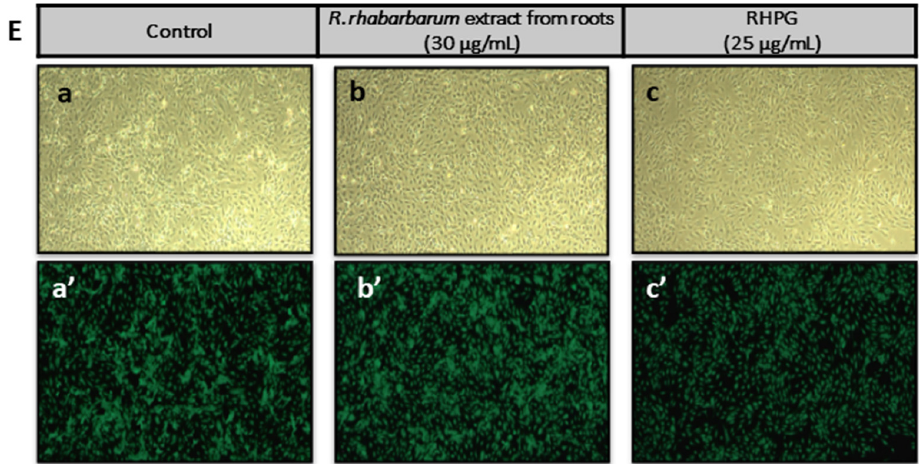
Figure 2. Effects of the examined substances on HUVEC viability. The figure presents the viability curves of HUVECs after 24 h of incubation with the petiole extracts from R. rhaponticum and R. rhabarbarum ( A ), the root extracts from R. rhaponticum and R. rhabarbarum ( B ), RHPG and RHPT ( C ) and reference anti-inflammatory drugs (indomethacin and zileuton) ( D ), at concentrations of 1–100 µ g/mL, established in the resazurin-based assay. Results derive from four independent experiments. Panel ( E ) presents the effects of R. rhabarbarum root extract ( b , b (cid:48) ) and RHPG ( c , c (cid:48) ) at concentrations of 30 and 25 µ g/mL, respectively. The ( a , b , c ) panels are the images of HUVECs in transmitted light, whereas the ( a (cid:48) , b (cid:48) , c (cid:48) ) panels represents the same HUVECs samples obtained from the fluorescence microscope. HUVECs were stained with 3 µ M Calcein-AM; images were acquired with 4 × magnification.